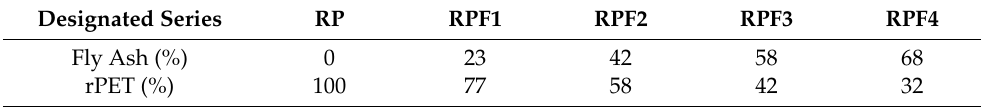
Table 4. Mix design of the fly ash–rPET waste composite material.